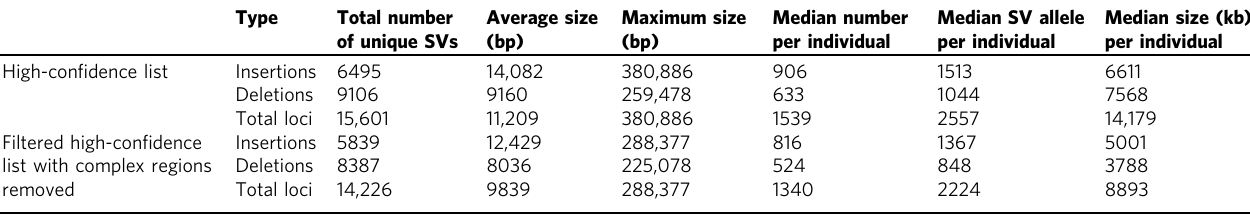
Table 1 Number of large (>2 kb) insertions and deletions identi fi ed from the 154 samples